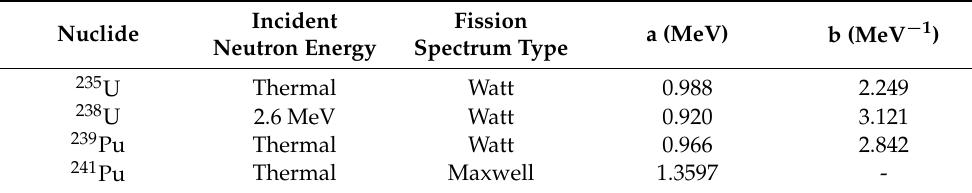
Table 2. Data for fission neutron spectrum